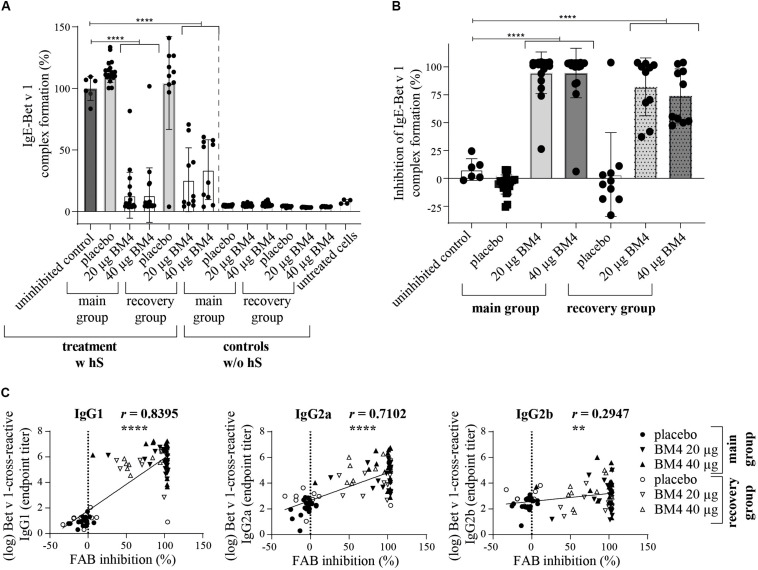
BM4-induced rat IgG antibodies are able to sufficiently inhibit CD23-mediated complex formation of Bet v 1 and human IgE antibodies on B cells. The inhibition FAB assay was performed with sera of rats of the repeated immunization model receiving either 0 (placebo), 20, or 40 μg BM4. The percentage of IgE-Bet v 1 complex formation (A) was normalized toward the mean of the uninhibited control (100%). Untreated cells were used as negative controls. For the evaluation of unspecific rat IgE-Bet v 1 complex formation, controls without human serum (w/o hS) were included; w hS, with human serum. The percentage inhibitory activity was calculated by subtracting the baseline activation of untreated cells followed by subtraction of the normalized IgE-Bet v 1 complex formation values from 100 (B). The column bar charts depict the mean and standard deviation of each data set. Statistics were calculated using a one-way ANOVA and a Dunnett’s multiple comparisons test comparing each treatment group with the uninhibited reference. Statistics of the controls (w/o hS) were excluded due to simplicity reasons but significantly lower than the uninhibited control (positive control, p = 0.0001). A Pearson correlation test was performed to analyze if the determined Bet v 1-cross-reactive IgG1, IgG2a, and IgG2b titers were correlating with the inhibition of IgE-Bet v 1 complex formation (C). ns >0.05; **p ≤ 0.01; ****p ≤ 0.0001.